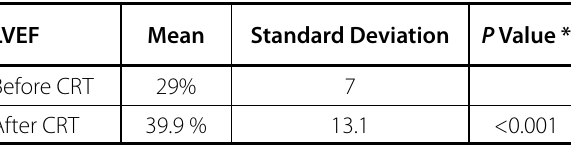
Table 3 . Left ventricular ejection fraction before and after CRT use.